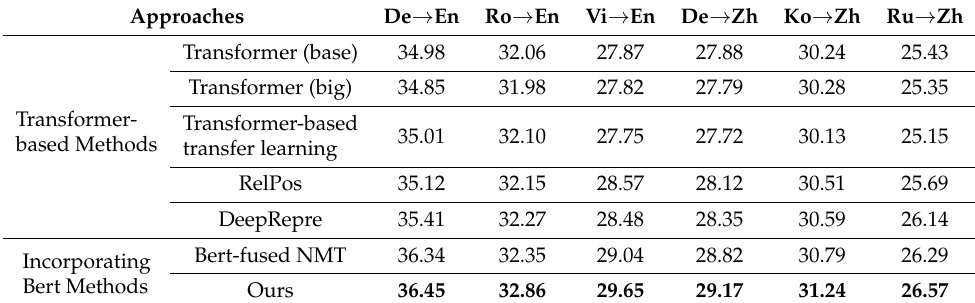
Table 2. The translation performance of the baselines and our approach.